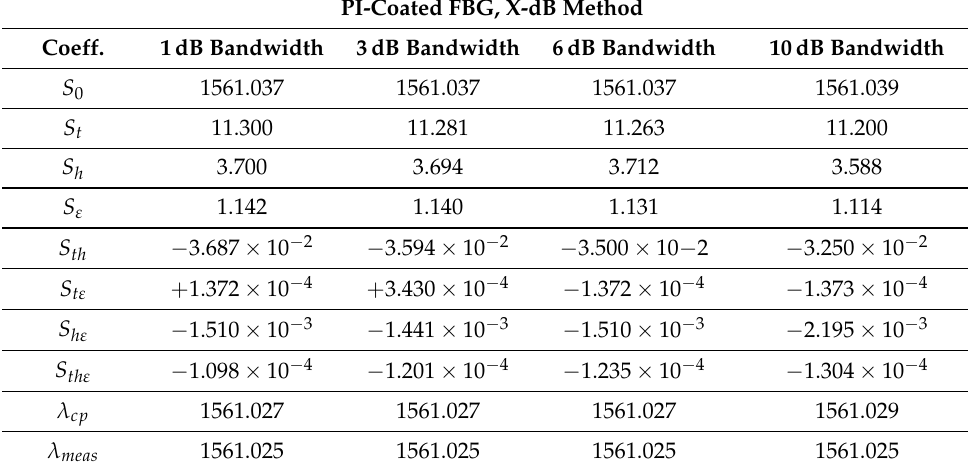
Table 3. Main and cross sensitivities of PI-coated FBG, calculated using factorial design in X-dB bandwidth algorithms.